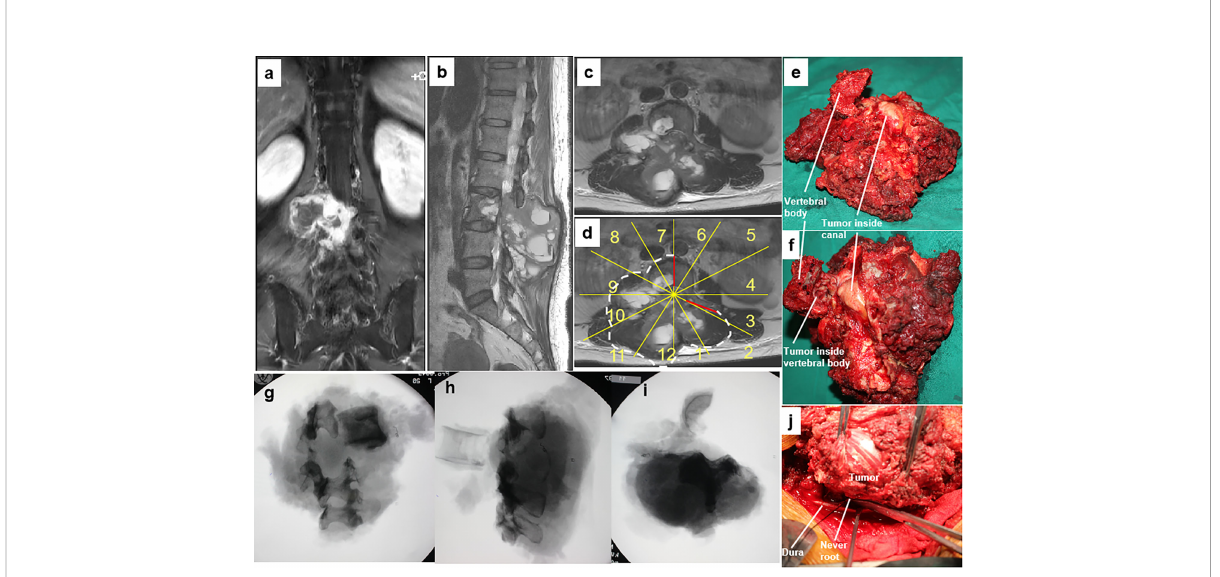
FIGURE 3 A 46-year-old woman with a malignant neurilemmoma at L3 with a huge mass in the posterior elements (A – C) . En bloc resection through a combined anterior and posterior approach was designed based on WBB classi fi cation along the margins, as highlighted by white dotted line (sectors 7 – 2, D, WBB) (D) . The dura was separated from the mass, and bilateral nerve roots of L3 were sectioned under direct visualization using the rotation technique (J) . Photographs of the gross specimen (E, F) showing that the epidural extension of the tumor was fully contained by the ligamentum fl avum. Radiographs of the specimen (G – I) showing the margins of en bloc resection. WBB, Weinstein – Boriani – Biagini.